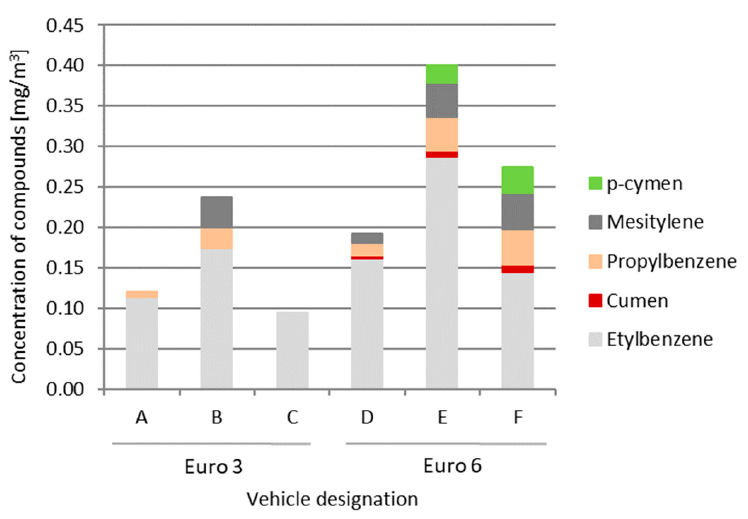
Figure 3. Quantitative assessment of aromatic hydrocarbon compounds (BTX omitted).